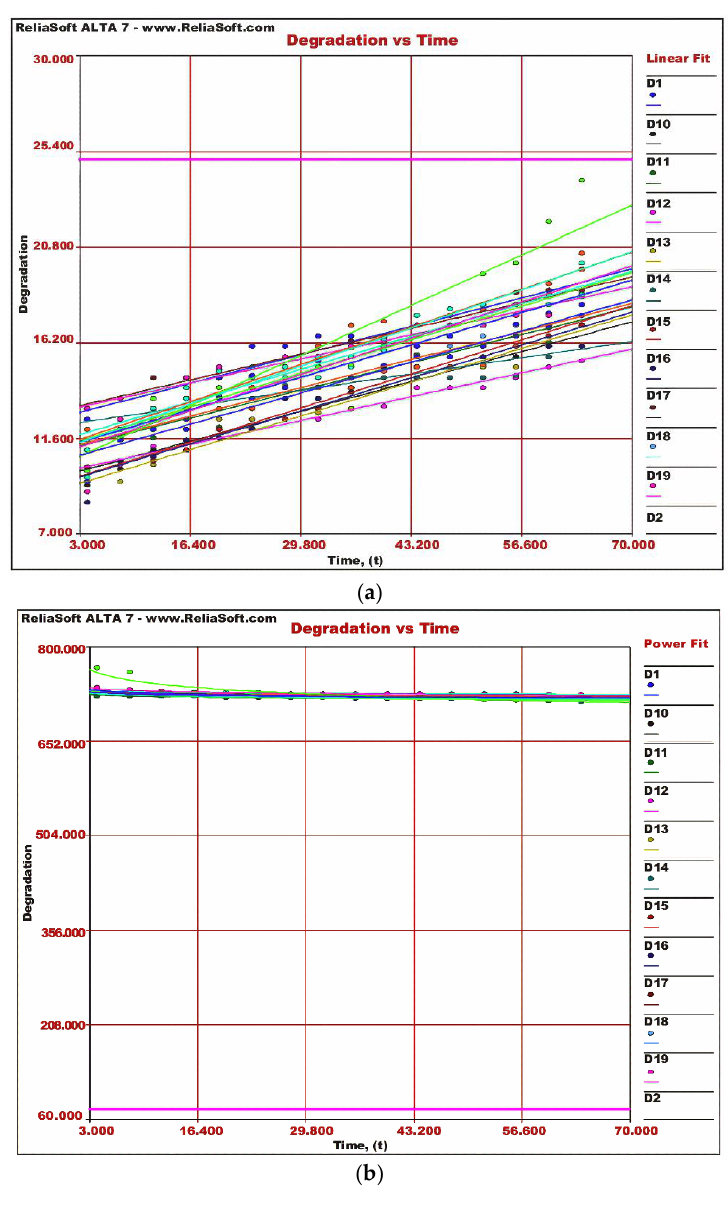
Figure 8. Degradation vs. time. ( a ) Diode I r vs. time; ( b ) diode V F vs. time.